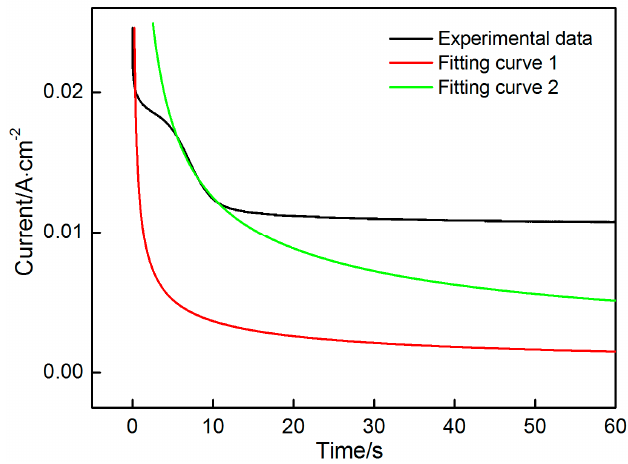
Figure 5. Fitting results in the first and third stages at the potential of 2.0 V.